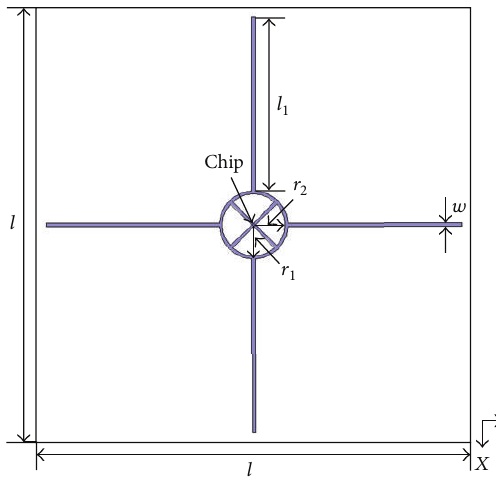
Figure 2: Structure of the proposed dual-dipole tag antenna. The substrate of the antenna is made of PTFE, with an area of 𝑙 × 𝑙 and a thickness of ℎ . Main dimensions of antenna radiator are determined by 𝑙 1 , 𝑙 2 , 𝑙 3 , and 𝑤 , and the sizes of feed loop are determined by 𝑟 1 and 𝑟 2 .